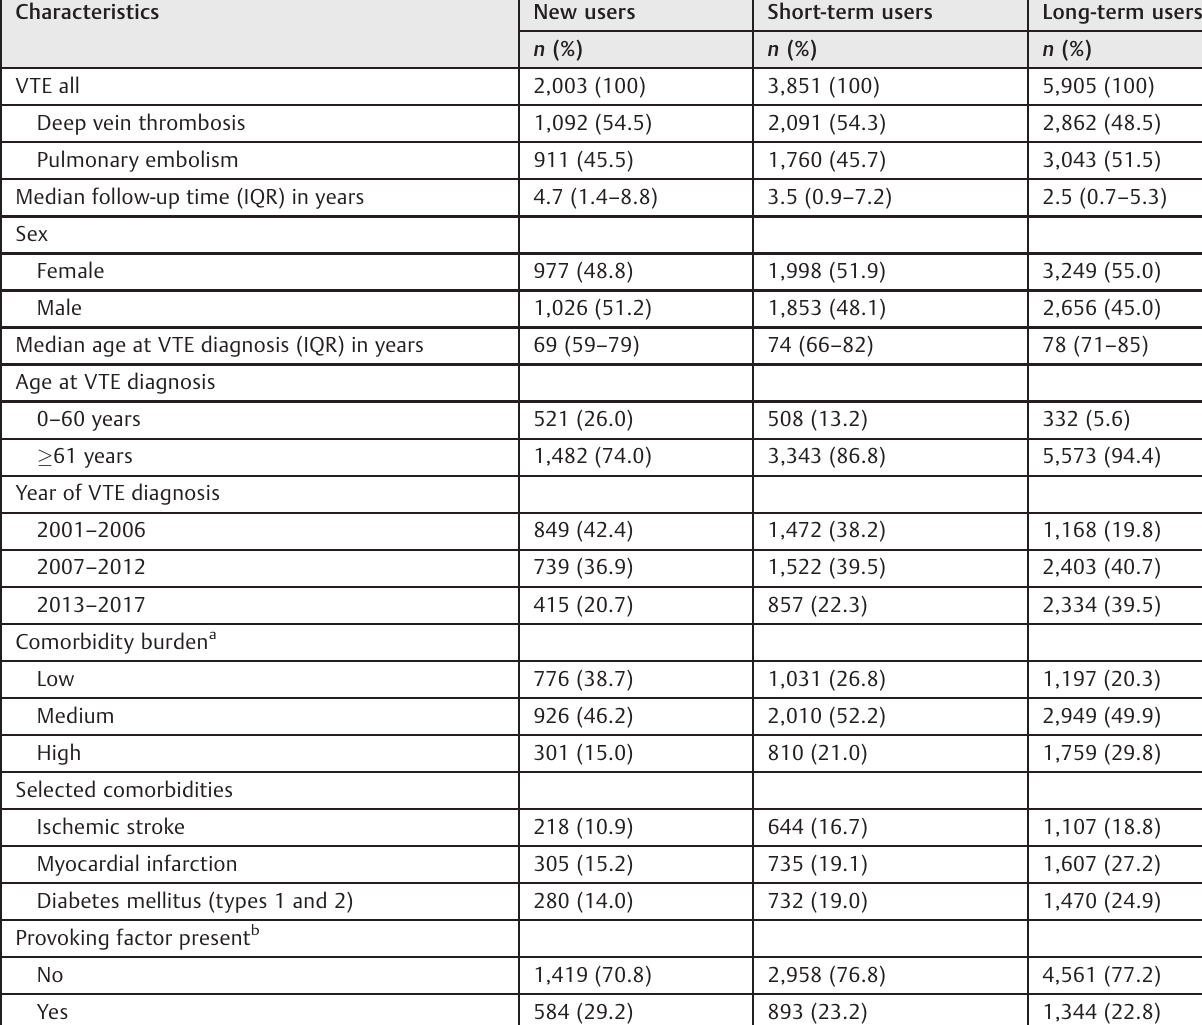
Table 1 Characteristics of users of low-dose aspirin with venous thromboembolism